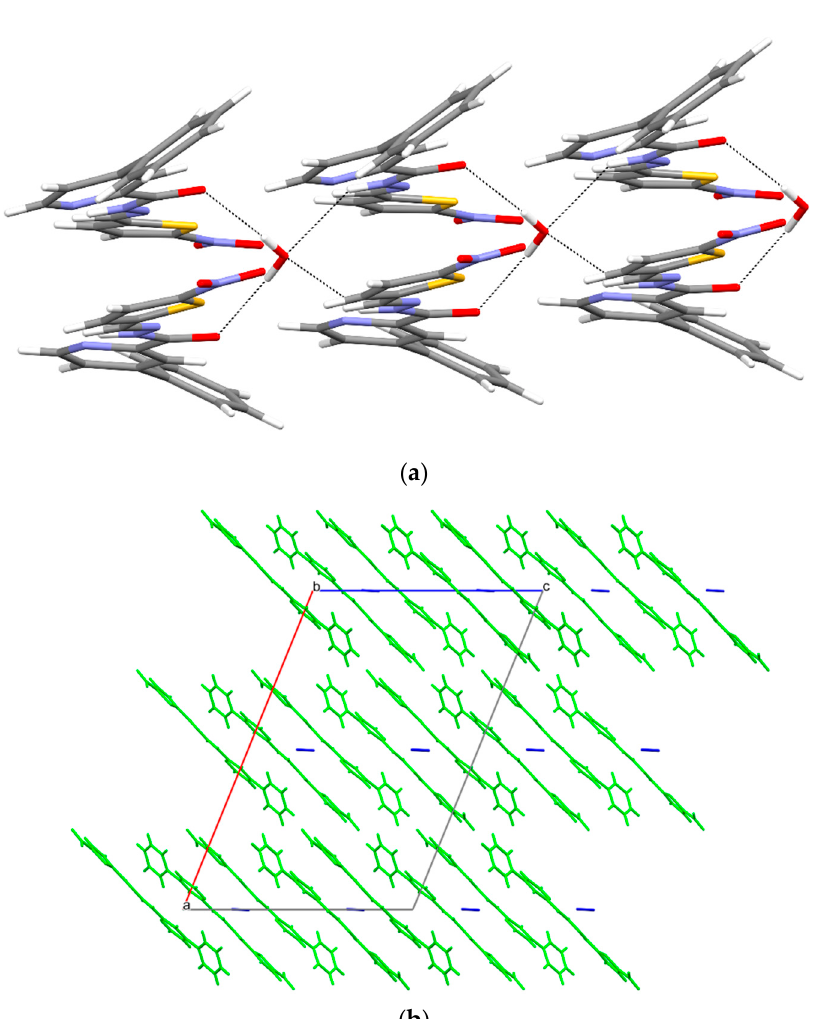
Figure 10. ( a ) Intermolecular hydrogen bonds in 4b . ( b ) The packing molecules in 4b (a, b, c–unit cell).